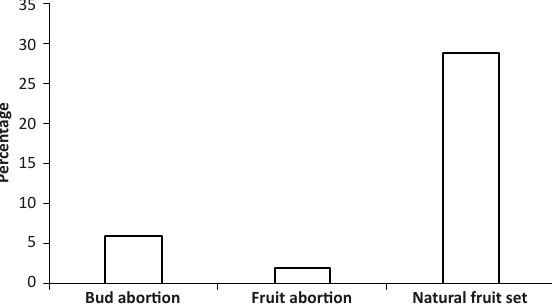
Figure 1. Bud, fruit abortion and natural fruit set rate in Derris trifoliata